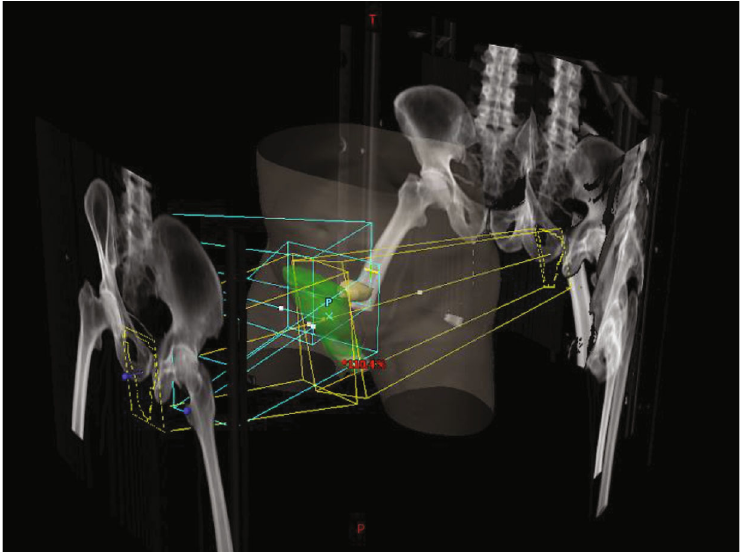
Figure 3: 3D reconstruction of radiotherapy